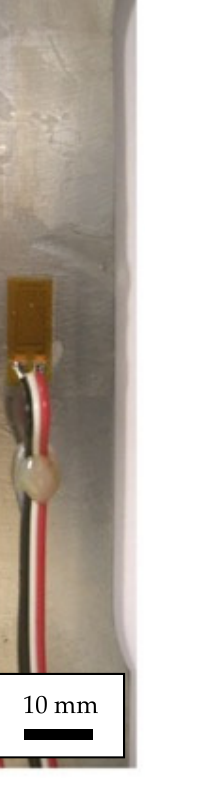
Metals 2021 , 11 , x FOR PEER REVIEW Figure 4. Strain gauges applied within adjacent grains in a flat plate specimen.